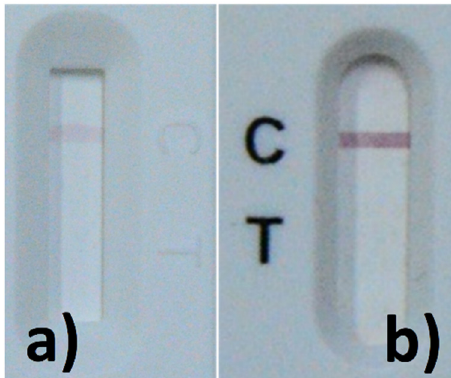
Figure 9: ( a ) Control line on the prototype LFIA strip and ( b ) control line on the commercial LFIA